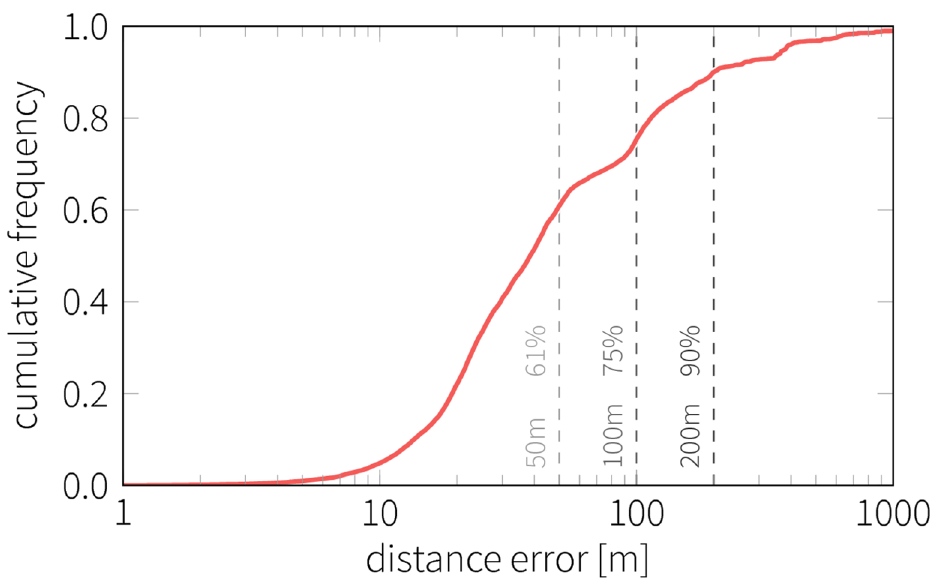
Fig 2. Accuracy of class location inference. The curve shows the cumulativedistribution of distanceerror, that is, the distancebetweenthe designated locationof the class and our estimationbasedon the location of the students. Dashedlines mark the distanceerrors of 50 m, 100 m and 200 m along with the corresponding percentage of classes with error below those thresholds.